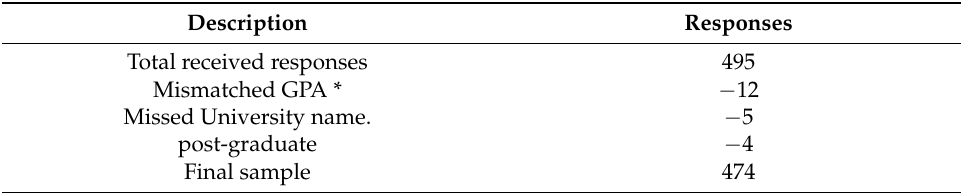
Table 1. Sample description.